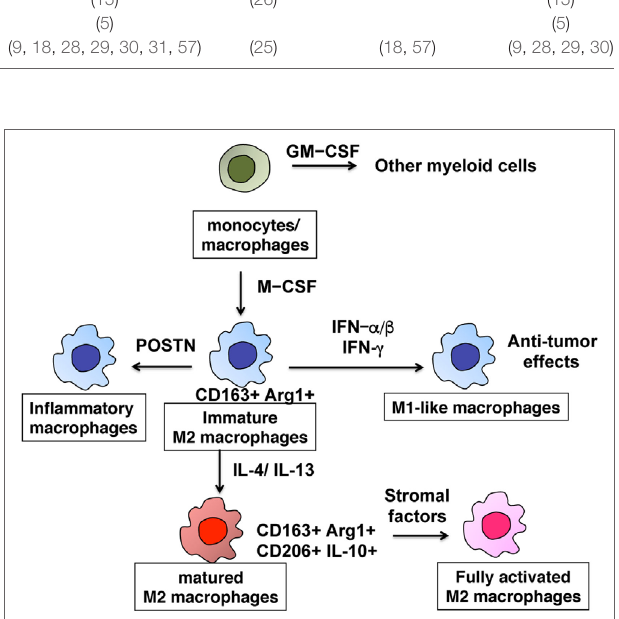
FigURe 1 | Differentiation of M2-polarized tumor-associated macrophages. The multiple steps of the development of monocytes into fully functional macrophages.